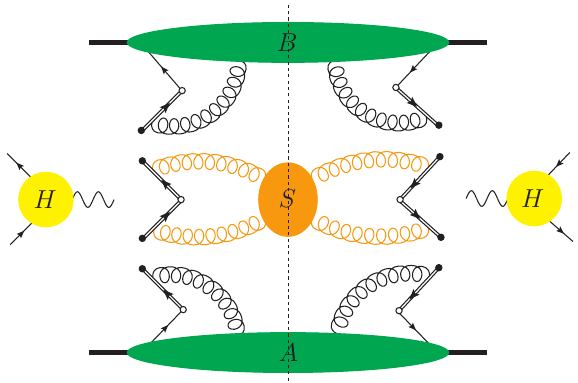
Figure 4: Factorised form of the DY process in the TMD formalism. We use the following notation for eikonal lines [ 3,41 ] : the circles at the ends of an eikonal line indicate the direction of momentum flow (from the full to the empty circle) of the original fermion, and the arrow on the line denotes the direction of colour flow (and thus also the direction of fermion number